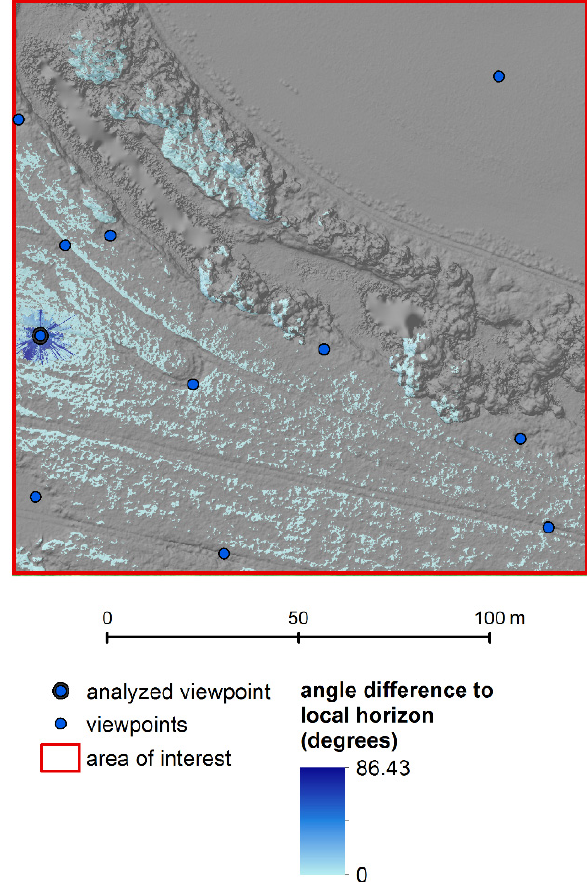
Figure 6. Extended viewshed - angle difference to the local horizon.